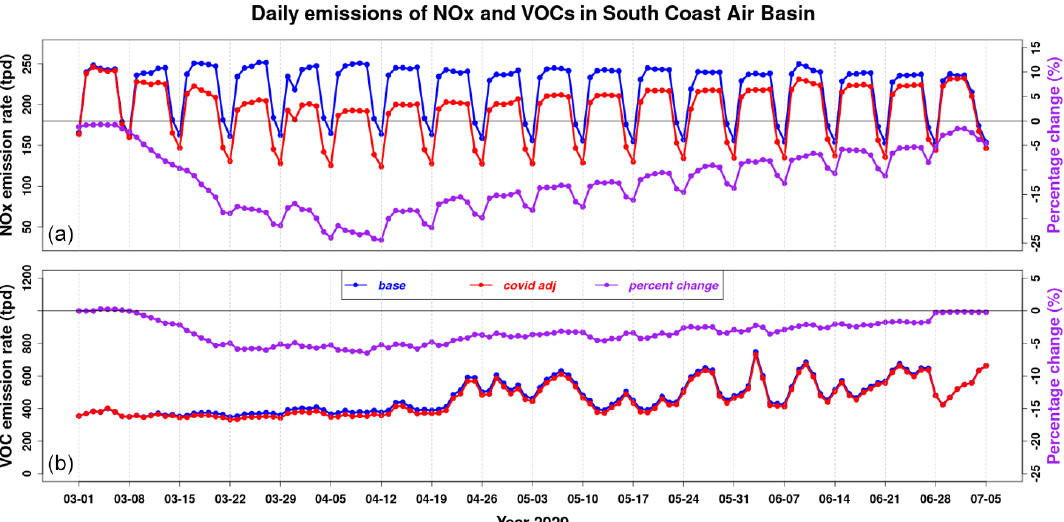
Figure 2. Daily total emissions of (a) NO x and (b) VOCs in the South Coast Air Basin. Blue lines denote the baseline emissions, red lines denote COVID-19-adjusted emissions, and purple lines denote the percentage change in NO x or VOCs due to the COVID-19 adjustment; the latter is calculated as follows: (COVID-19-adjusted − baseline) / baseline. Vertical gray dash lines correspond to Sundays.